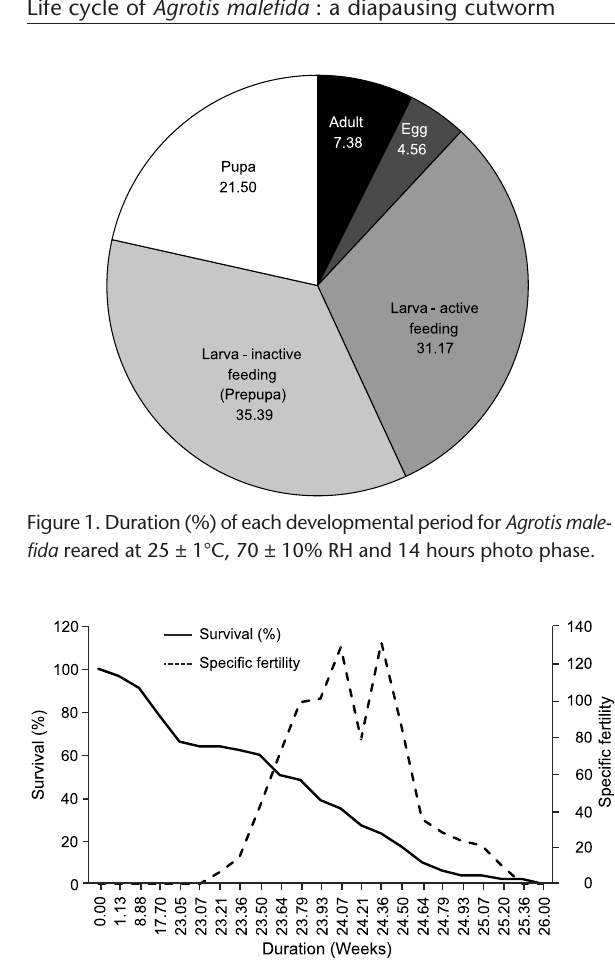
Figure 2. Relationship between specific fertility (mx) and survival rate (lx) during the development of Agrotis malefida reared on an artificial diet at 25 ± 1°C, 70 ± 10% RH and 14 hours photo phase.